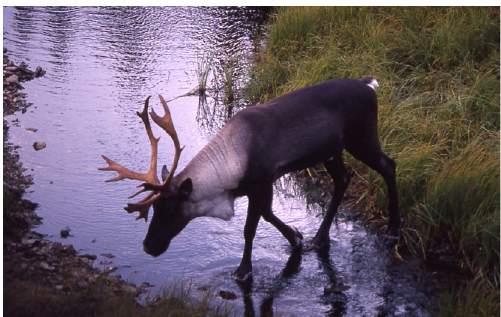
Figure 1. A photograph of our study organism, the woodland caribou ( Rangifer tarandus ) taken by Tim Timmermann, retired from the Ontario Ministry of Natural Resources and